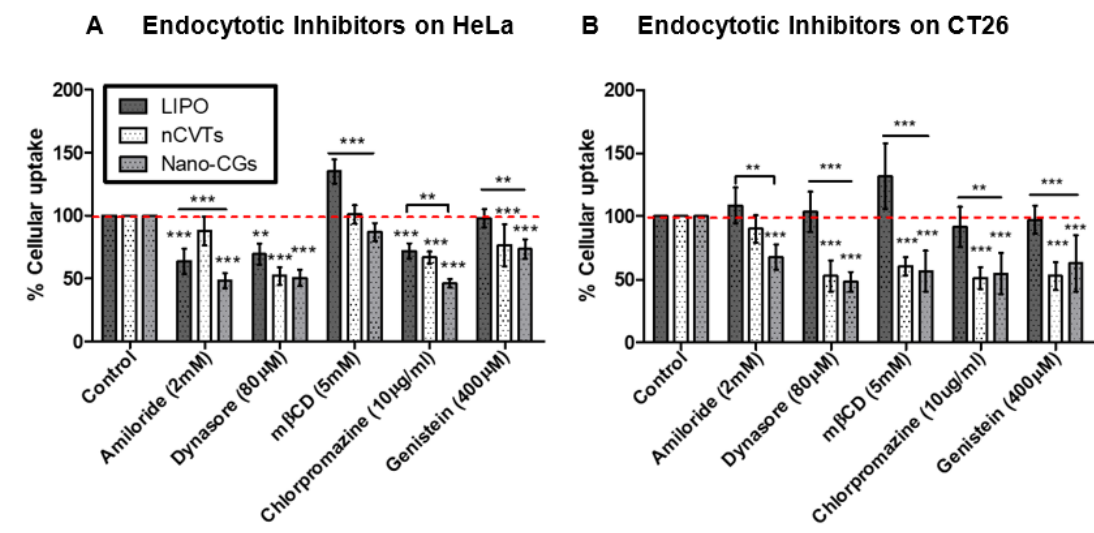
Figure 7. Summary of uptake of nCVTs, liposomes (LIPOs), and nano-CGs in the presence of respective inhibitors by ( A ) HeLa cells and ( B ) CT26 cells; ( n = 5/group) ** p < 0.01, and *** p <